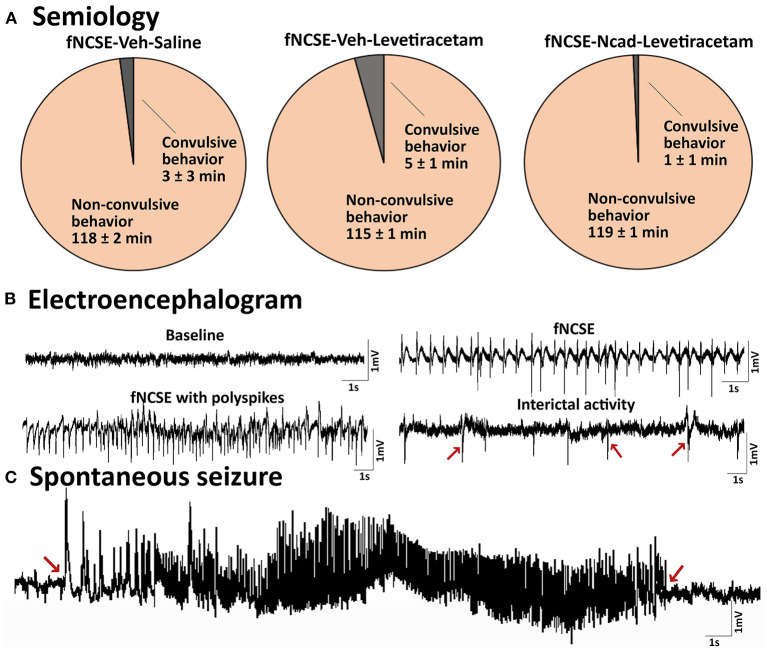
Seizure semiology and electroencephalogram in rats with focal non-convulsive status epilepticus (A) Pie charts showing mean percentage of time rats exhibit focal non-convulsive seizure semiology during 2 hours of self-sustained fNCSE in fNCSE-Veh-Sal, fNCSE-Veh-Lev and fNCSE-N-cad-Lev rats. (B) Representative baseline activity before stimulation, epileptiform activity during self-sustained fNCSE (1-3Hz), fNCSE activity with polyspiking, interictal epileptiform activity (indicated by arrows), (C) an example of spontaneous seizure with an evolving seizure pattern. Arrows mark the beginning and end of the seizure.